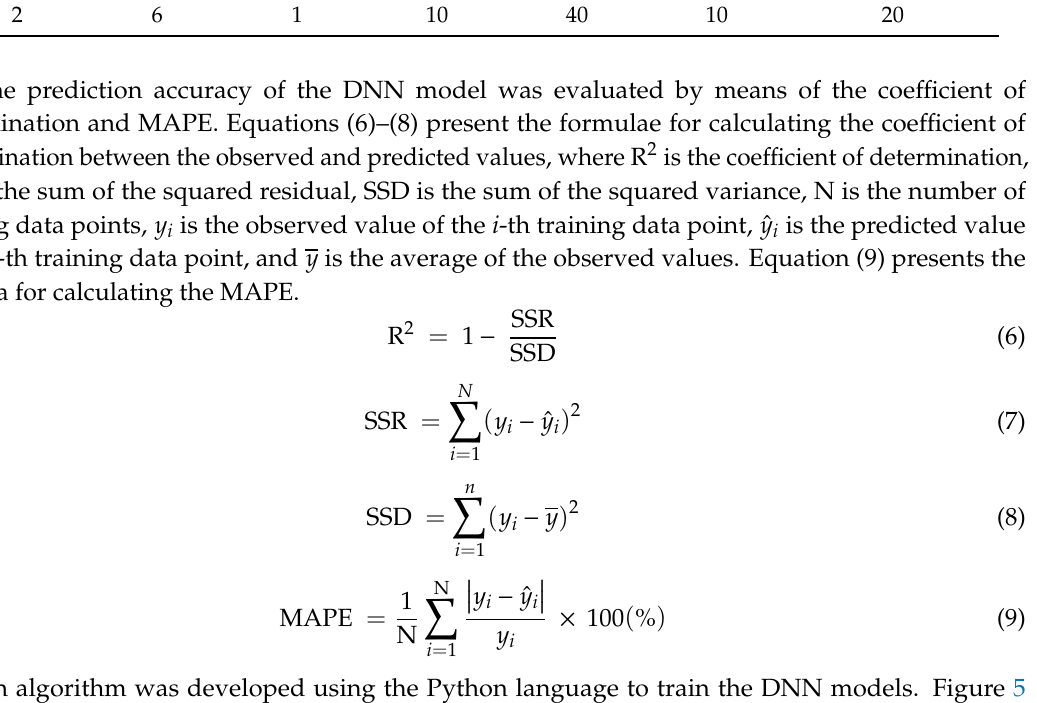
Table 4. Description of hidden layer setting of DNN model. Configuration of the Hidden Layer No. of Hidden